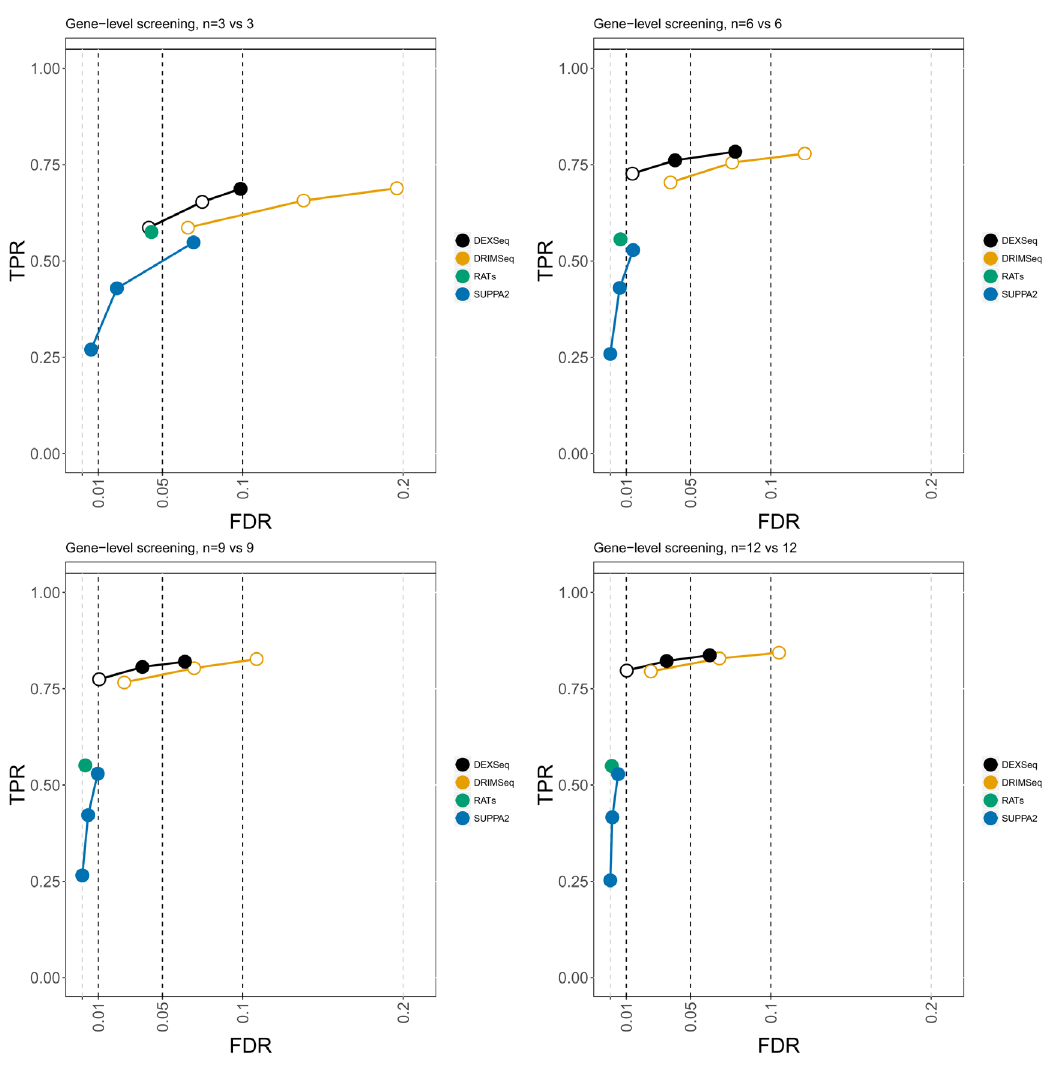
Figure 6. Gene-level screening for differential transcript usage (DTU). True positive rate (y-axis) over false discovery rate (FDR) (x-axis) for DEXSeq, DRIMSeq, RATs, and SUPPA2. The four panels are for per-group sample sizes: 3, 6, 9, and 12, as indicated in the title. Circles indicate thresholds of 1%, 5%, and 10% nominal FDR, which are filled if the observed value is less than the target (dashed vertical